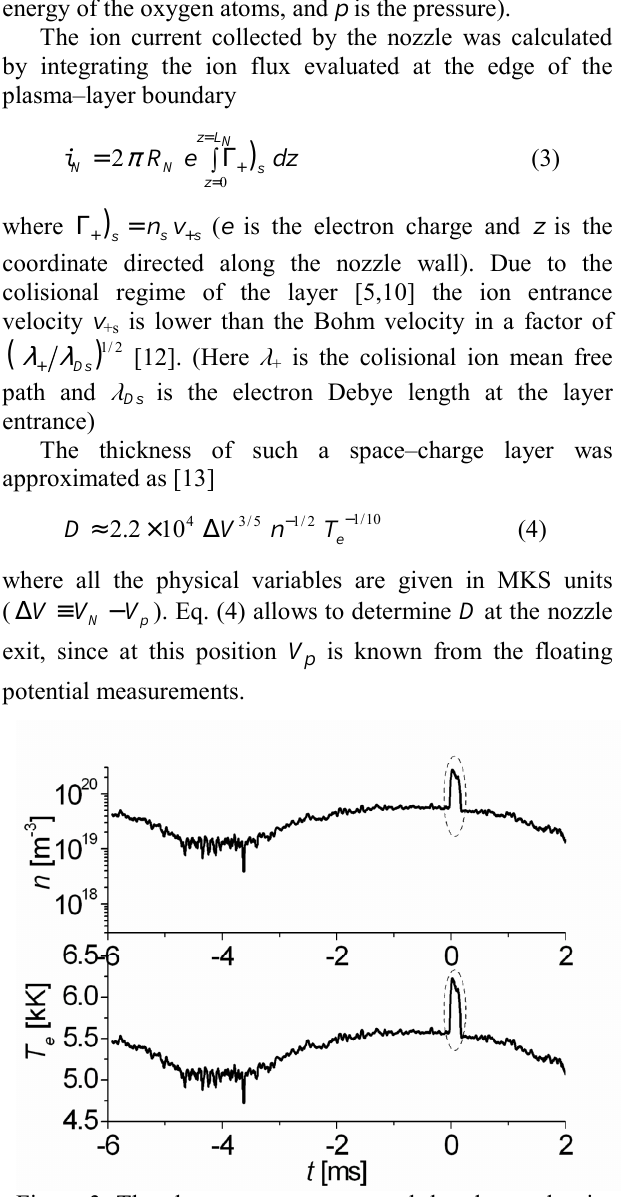
Figure 3: The electron temperature and the plasma density calculated from the experimental results showed in Fig. 2. The formulation also includes